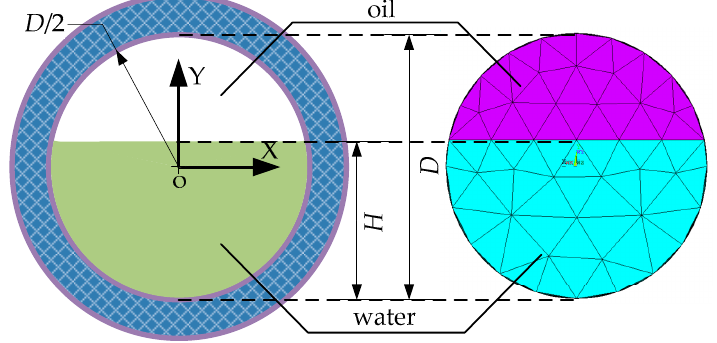
Figure 12. Oil-water contact interface and 2D view of the finite element model for segregated flow sketches.